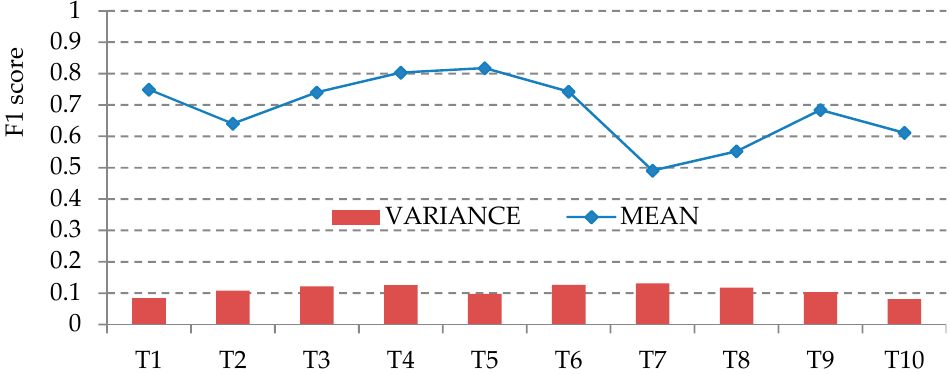
Figure 5. Illustration of the mean and variance of F1 scores on the 36 FCN models for each of the 10 test data with different parameter settings, as indicated in Table 2.